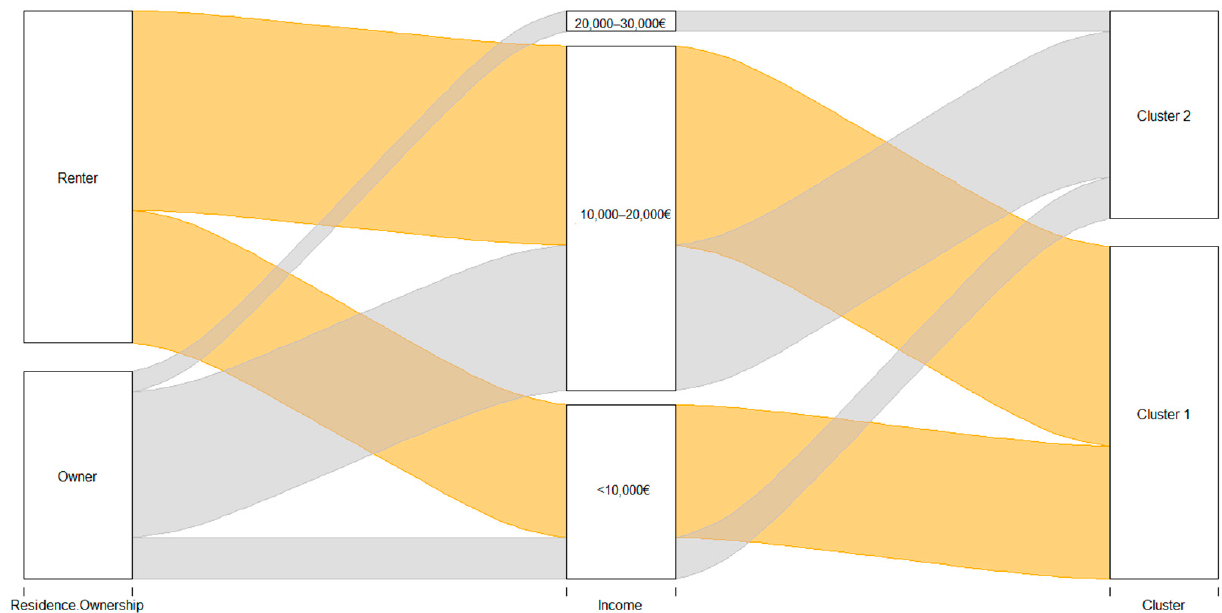
Figure 7. Clustering of the socioeconomic status of the participants who are unwilling to pay.